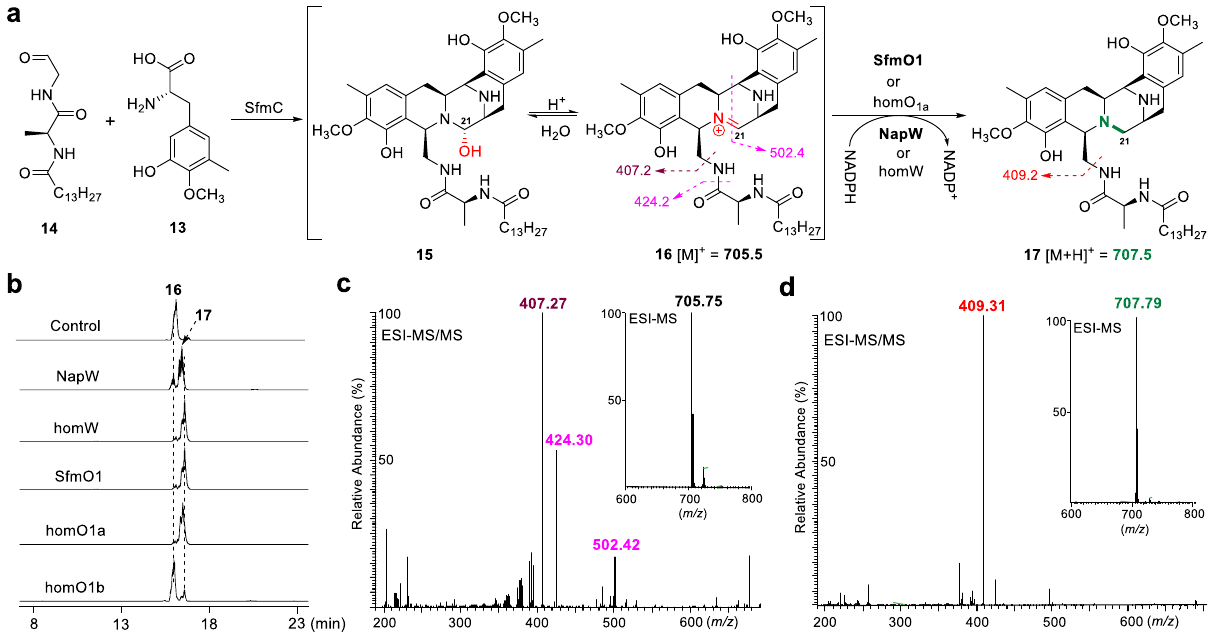
Fig. 5 Biochemical investigation of SDRs-catalyzed pharmacophore reductive quenching in SFM biosynthesis. a Enzymatic reactions mediated by SfmC and SDRs. b LC-MS analysis of enzymatic reaction products. c ESI-MS and ESI-MS/MS analysis of 16 generated by SfmC. d ESI-MS and ESI-MS/MS analysis of 17 generated by